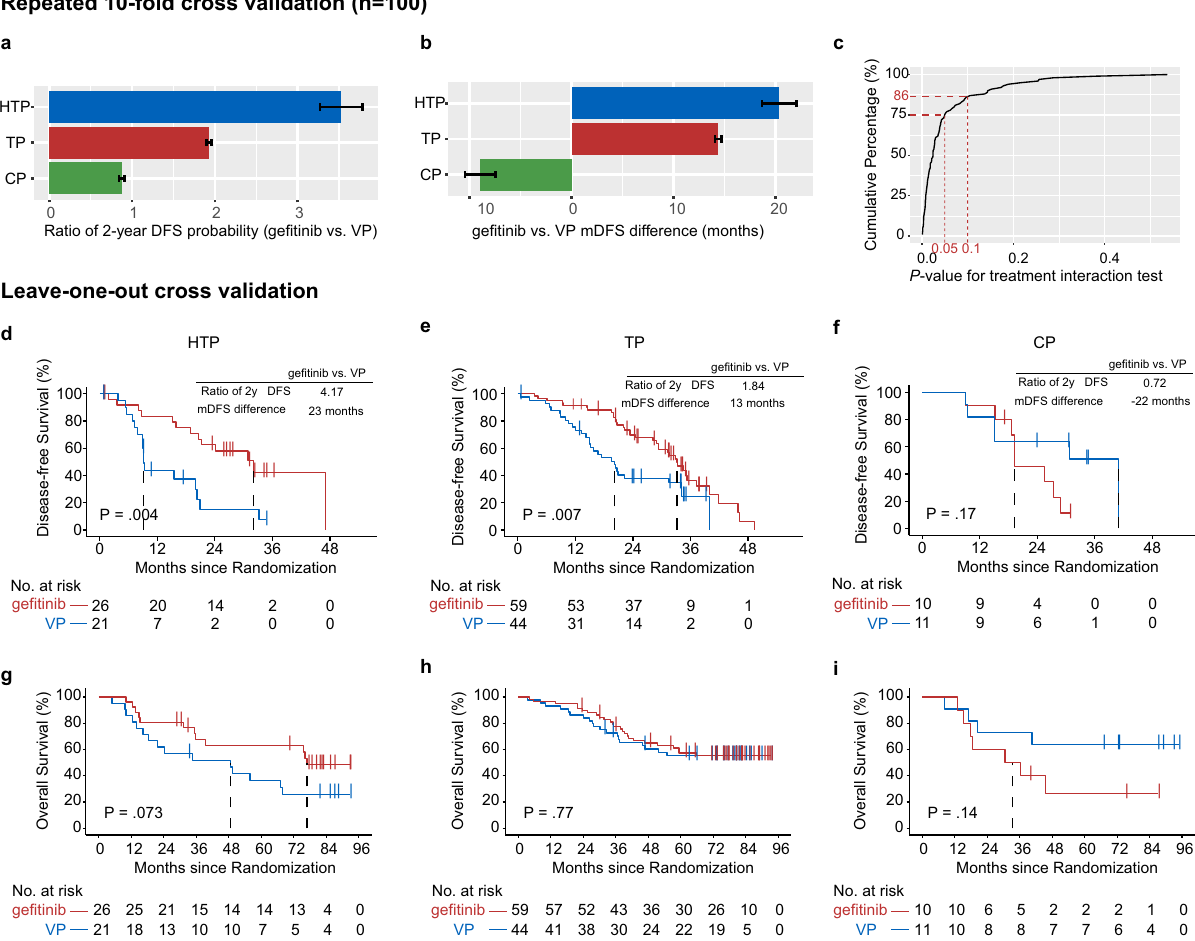
Fig. 4 Internal validation of MINERVA. a , b Ten-fold cross validation was repeated 100 times to assess relative bene fi t among three MINERVA risk groups by ( a ) mean ratio of 2-year disease-free survival (DFS) probability comparing ge fi tinib to VP from 100 repeats, and ( b ) mean difference in median DFS between ge fi tinib and VP treated patients from 100 repeats. Error bars indicate standard error of 100 repeats in each subgroup. c Curve showing the cumulative percentage of mock MINERVA models from 100 repeated 10-fold cross validation and corresponding p-values derived from the MINERVA-by- treatment interaction tests. Red dotted lines indicate percentage of repeats with interaction P < 0.05 or <0.1 (two-sided, wald test). d – f Kaplan-Meier estimates of DFS in three mock MINERVA subgroups derived by leave-one-out cross validation. P values were derived from the two-sided log-rank test. g – i Kaplan-Meier estimates of OS in three mock MINERVA subgroups. P values were derived from the two-sided log-rank test. Source data used to generate this fi gure are provided as a Source Data fi